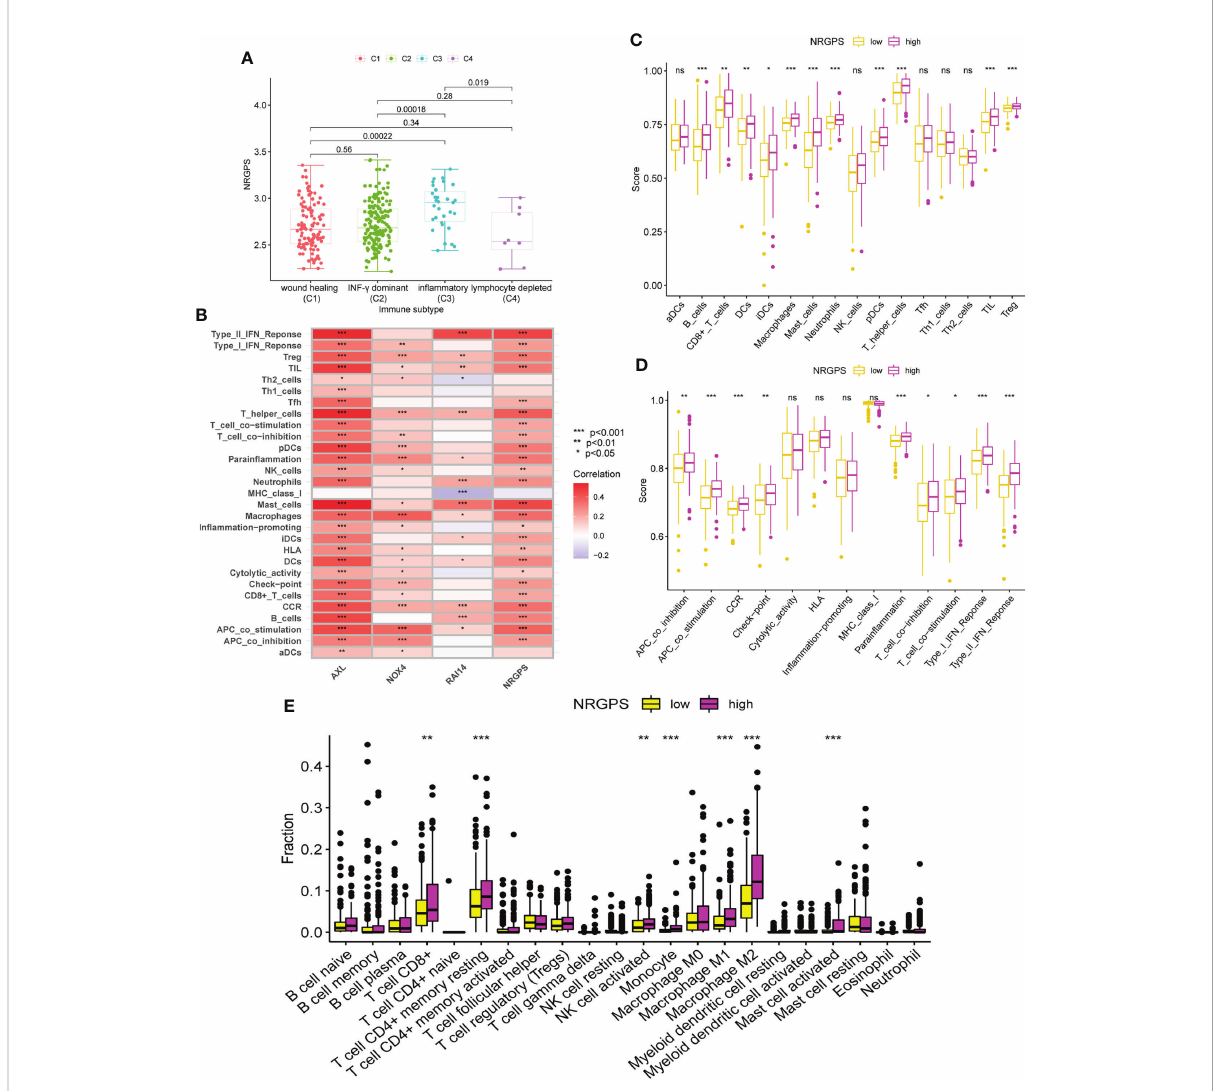
FIGURE 8 Analysis of immune subtypes and immune cell in fi ltration in the TCGA cohort. (A) The boxplot of differences in NRGPS between immune subtype groups. (B) Correlation analysis of NRGPS and 3 candidate genes with immune cells and signaling pathways (ssGSEA algorithm). (C) The boxplot of 16 immune cell differences in the low- and high-NRGPS groups (ssGSEA algorithm). (D) The boxplot of 13 immune signaling pathway differences in the low- and high-NRGPS groups (ssGSEA algorithm). (E) The boxplot of 22 immune cell in fi ltration differences between high- NRGPS and low-NRGPS groups in TCGA cohort (CIBERSORT-ABS algorithm). NRGPS, necroptosis-related gene prognostic score; ssGSEA, single sample gene set enrichment analysis. * p < 0.05, ** p < 0.01, *** p < 0.001, ns, not signi fi